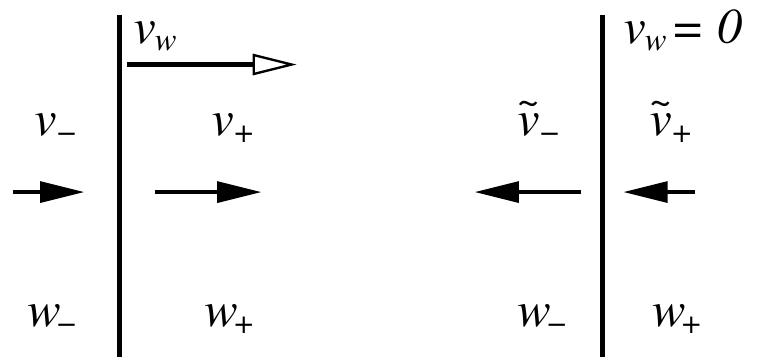
Figure 12: Fluid velocities right ahead of and behind the wall in the case of a su- personic deflagration. The velocities just ahead the wall are denoted by + while the velocities just behind the wall are denoted by a − subscript. The left panel shows the velocities in the universe rest frame in which the wall moves with the speed v right panel shows the velocities in the wall rest frame where v we indicate the fluid velocities in this frame by a tilde, ˜ v ± . The enthalpy is denoted by w . Figures taken from Ref. [ 66 ]